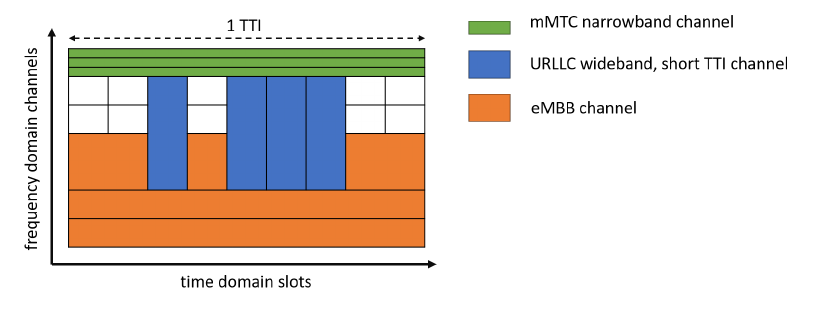
Figure 9. Network slicing in the